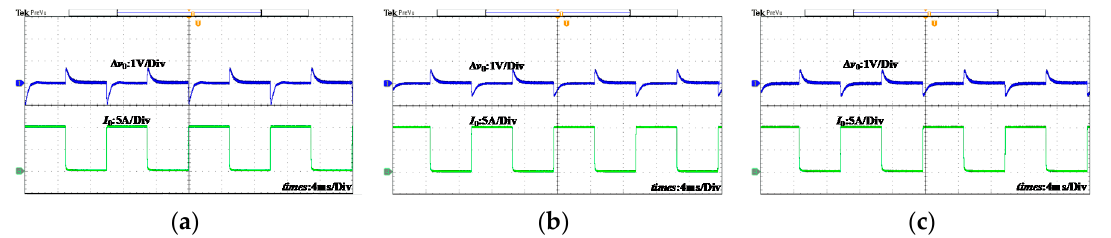
Figure 11. Experimental waveforms of dynamic response with the slope of d i / d t = 2.5 A / µ s for di ff erent